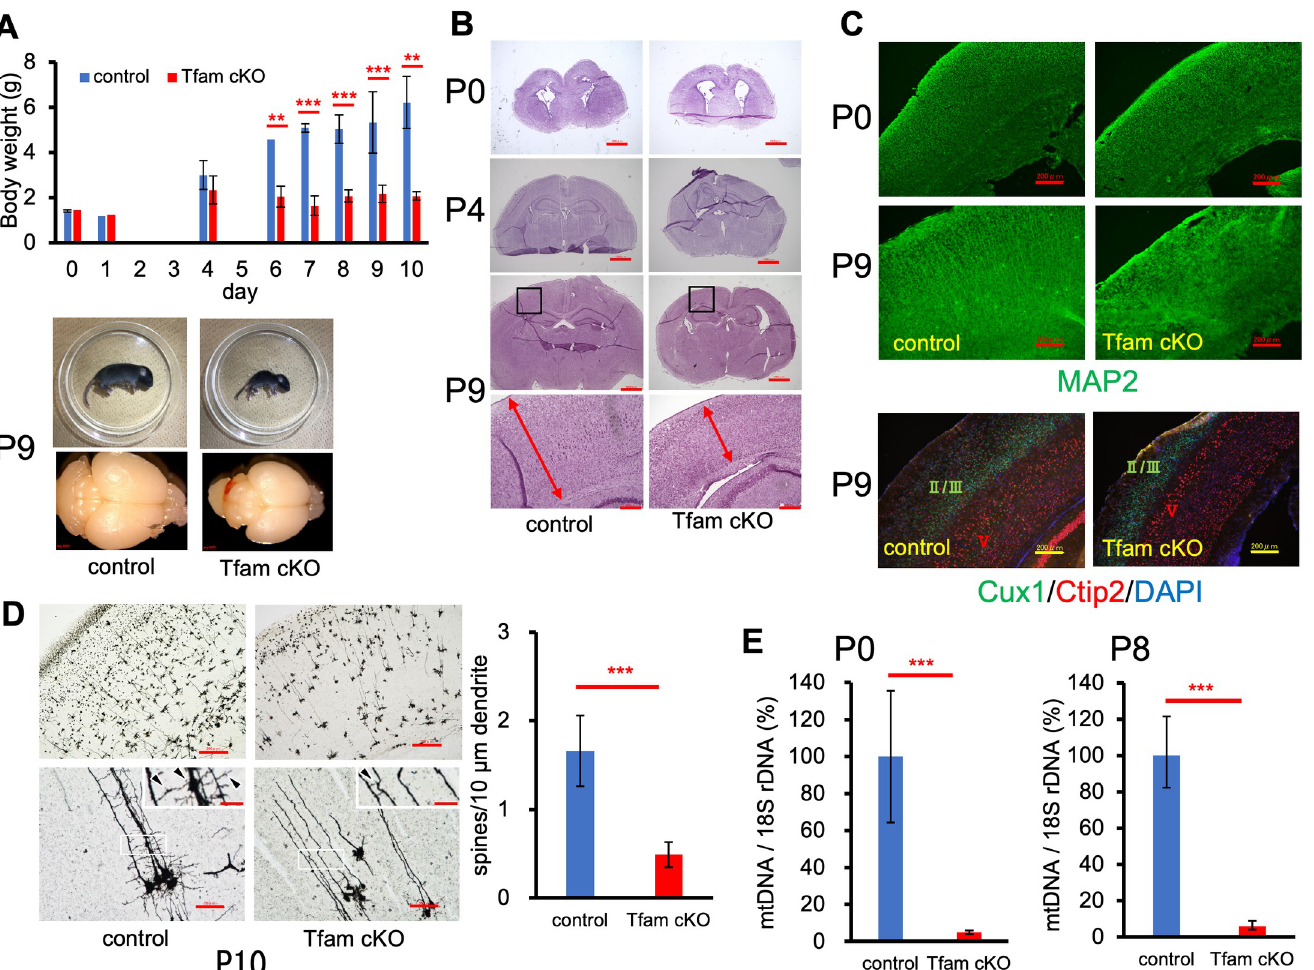
Fig 1. Tfam inactivation in neural stem cells (NSCs) results in postnatal growth retardation and neuronal maturation defects. (A) Measurement of body wight after birth. Body wight was measured on the indicated day. Representative images of mice at P9 are shown at the bottom. Graph shows means ± SD. At least n = 3 mice per group. �� P < 0.01; ��� P < 0.001. (B) Representative images stained with H&E at P0, P4, and P9. Enlarged view in the inset of P9 panels is shown at the bottom. Scale bars, 1000 μ m, 200 μ m in enlarged view. (C) Representative images of brains at P0 and P9 stained for MAP2 by immunofluorescence. Immunostaining of brains for layer-specific marker proteins, Cux1 (Layer II/III) and Ctip2 (layer V), at P9. DAPI was used for nuclear staining. Scale bars, 200 μ m. (D) Representative images at low (upper images) and high (lower images) magnification of control (left) and Tfam cKO (right) brain sections with Golgi staining at P10. Areas marked with white rectangles are enlarged in insets showing dendritic arborization and spines (arrowheads). Scale bars, 200 μ m for upper panels, 50 μ m for lower panels, 20 μ m for inset in lower panels. Quantification of the spine number per 10 μ m dendrite. Graph shows means ± SD. ��� P < 0.001. (E) Quantitative PCR analysis of relative mtDNA copy number in control and Tfam cKO brains at P0 and P8. Graph shows means ± SD. n = 3 mice per group. ��� P < 0.001. At least two independent experiments were performed.